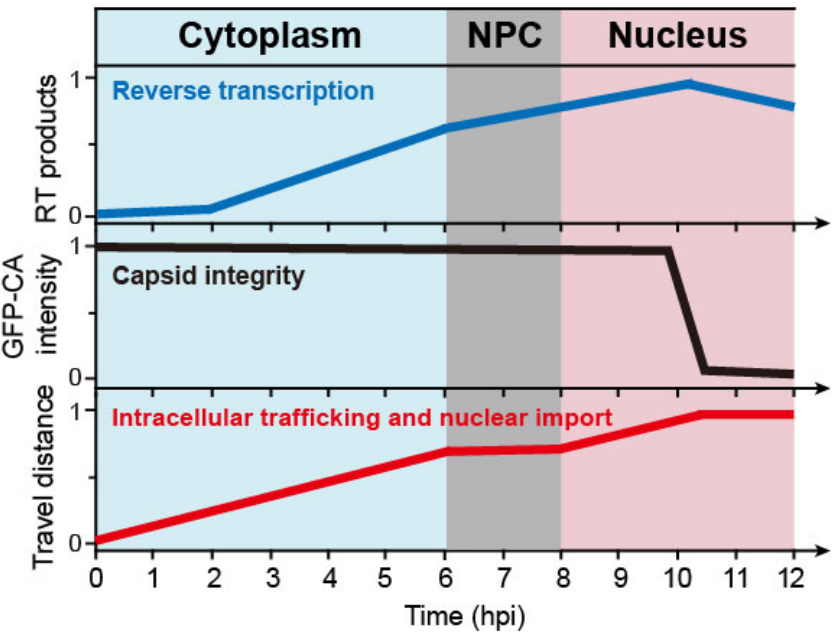
Figure 2. Schematic of the timelines for successful early-stage HIV-1 infection steps, including reverse transcription, uncoating, and nuclear import. The intact HIV-1 core penetrates the NPC independent of reverse transcription. The virus core completes reverse transcription and uncoats inside the nucleus. RT products—normalized amount of reverse transcription products; GFP-CA intensity—normalized GFP-CA signal intensity; travel distance—normalized distance from the periphery of the cytoplasm to the integration sites. The x and y -axis values are estimated from different sources [12,13,20–22,24–30].